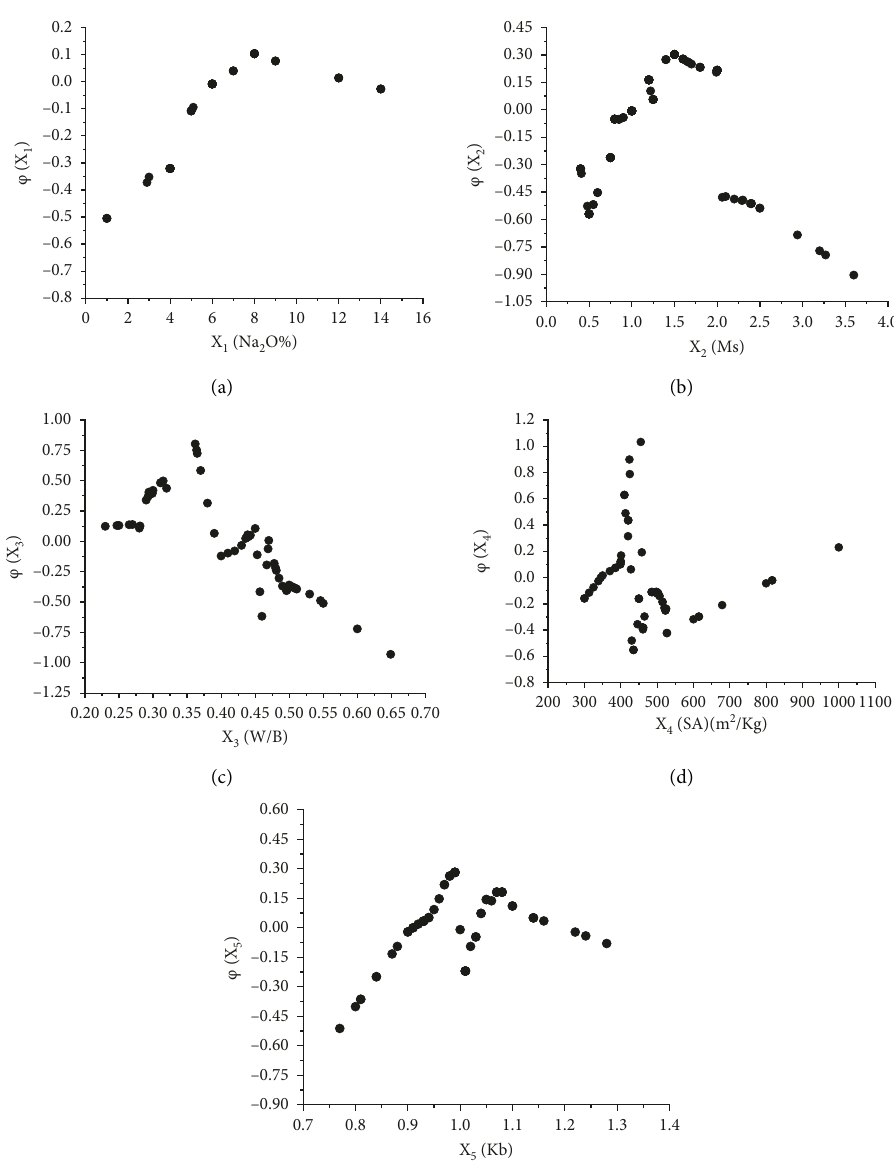
Figure 5: Relationship between input parameters and their corresponding response surface functions in the case of 28 d compressive strength. (a)X